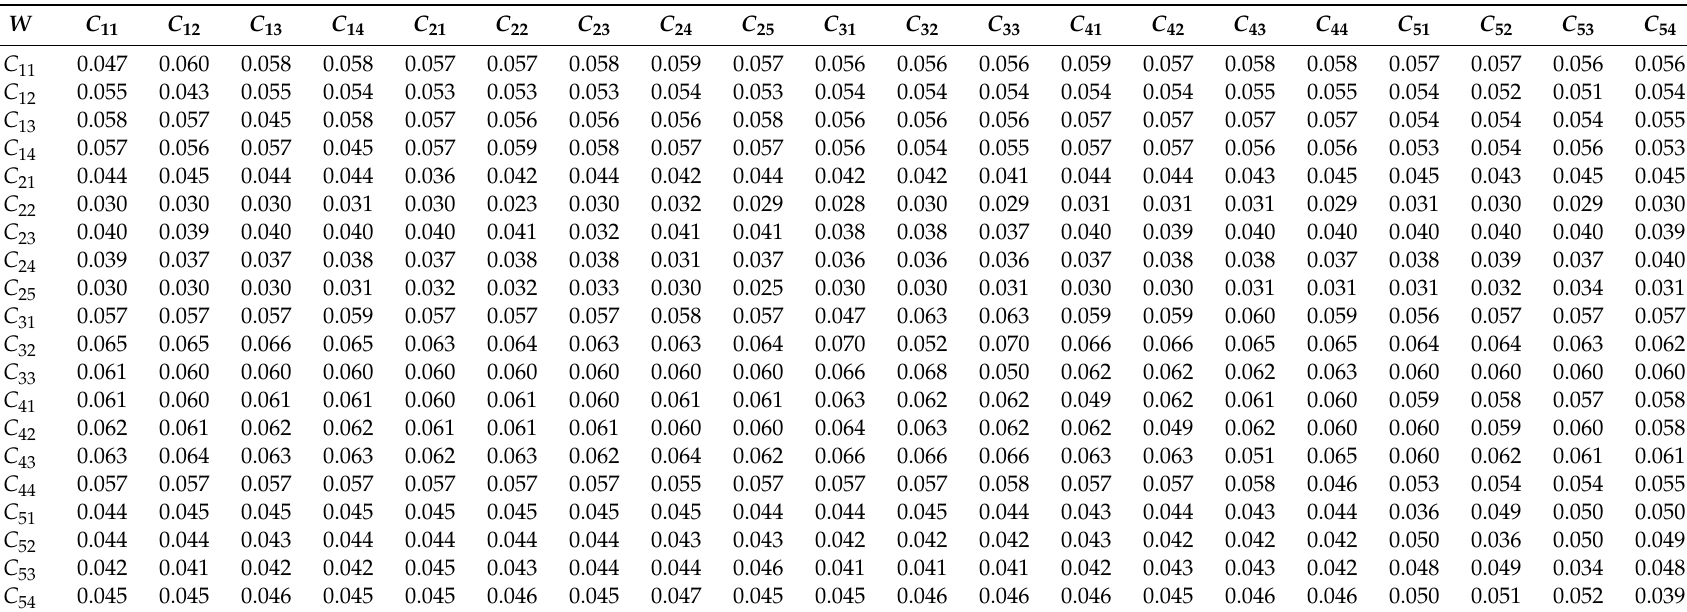
Table A7. The weighted supermatrix of criteria